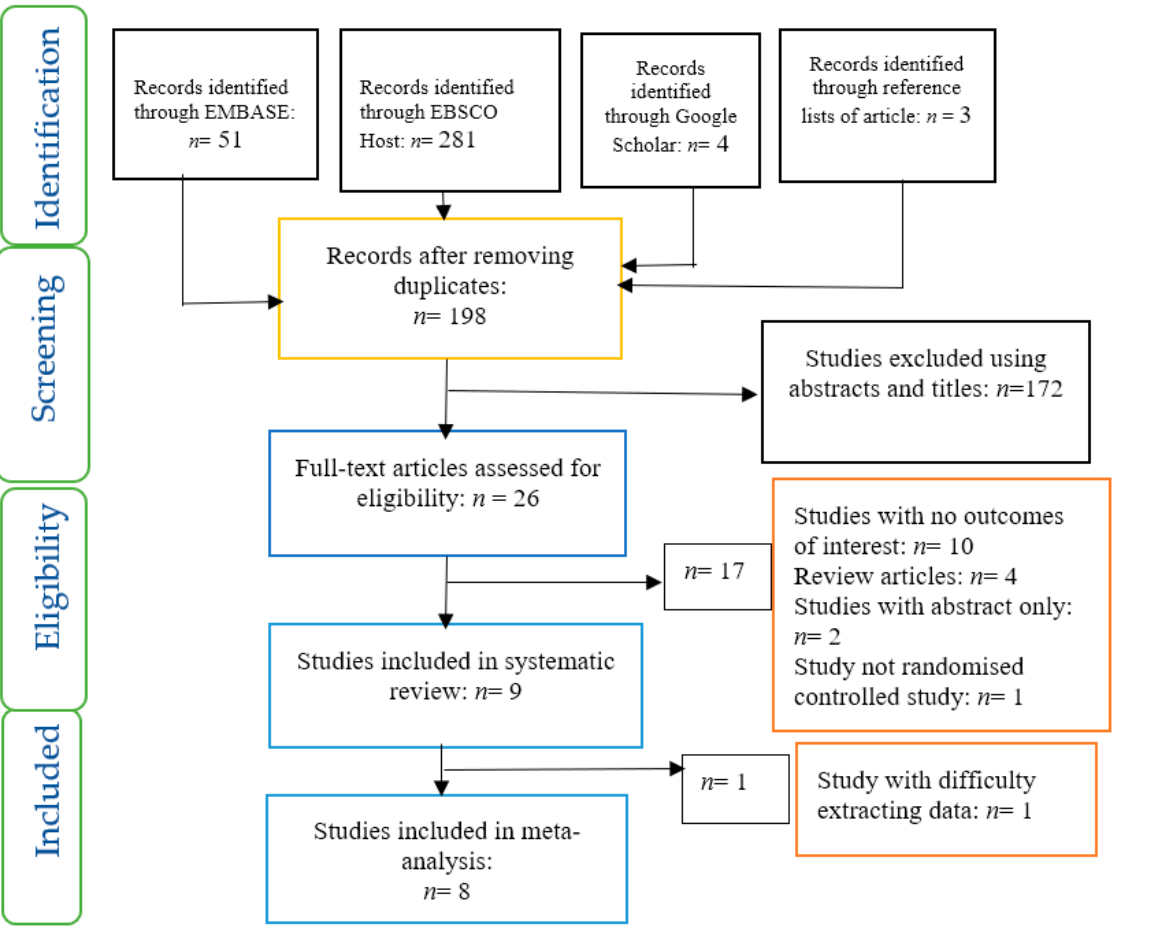
Figure 1. PRISMA flow chart on selection and inclusion of studies.